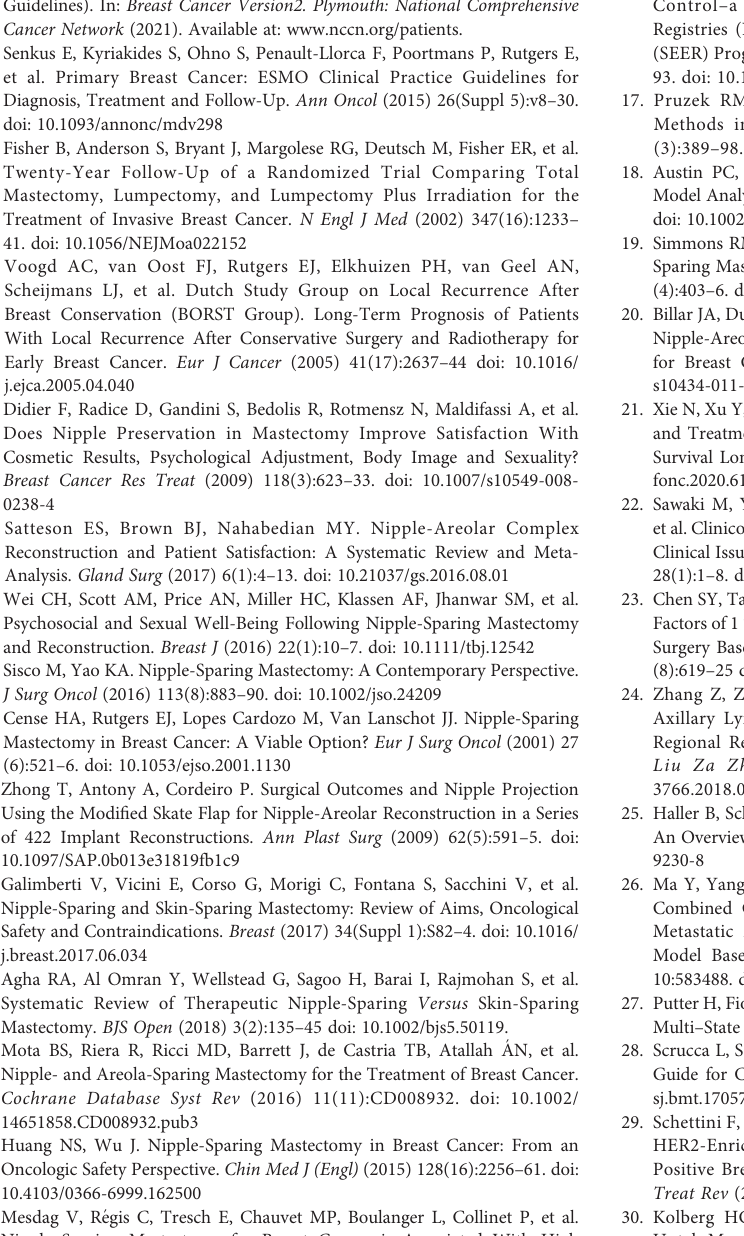
(A) Overall survival curves in NE-BCT group and NS-BCT group. (B) Breast cancer speci fi c survival curves in NE-BCT group and NS-BCT group. Supplementary Figure 5 | Multivariate Cox regression model forest graph between 2010 and 2015 before PSM. Supplementary Figure 6 | Cumulative incidence of breast cancer-speci fi c of death (BCSD) and other causes of death (OCSD) in NE-BCT group and NS-BCT group between 2010 and 2015 before